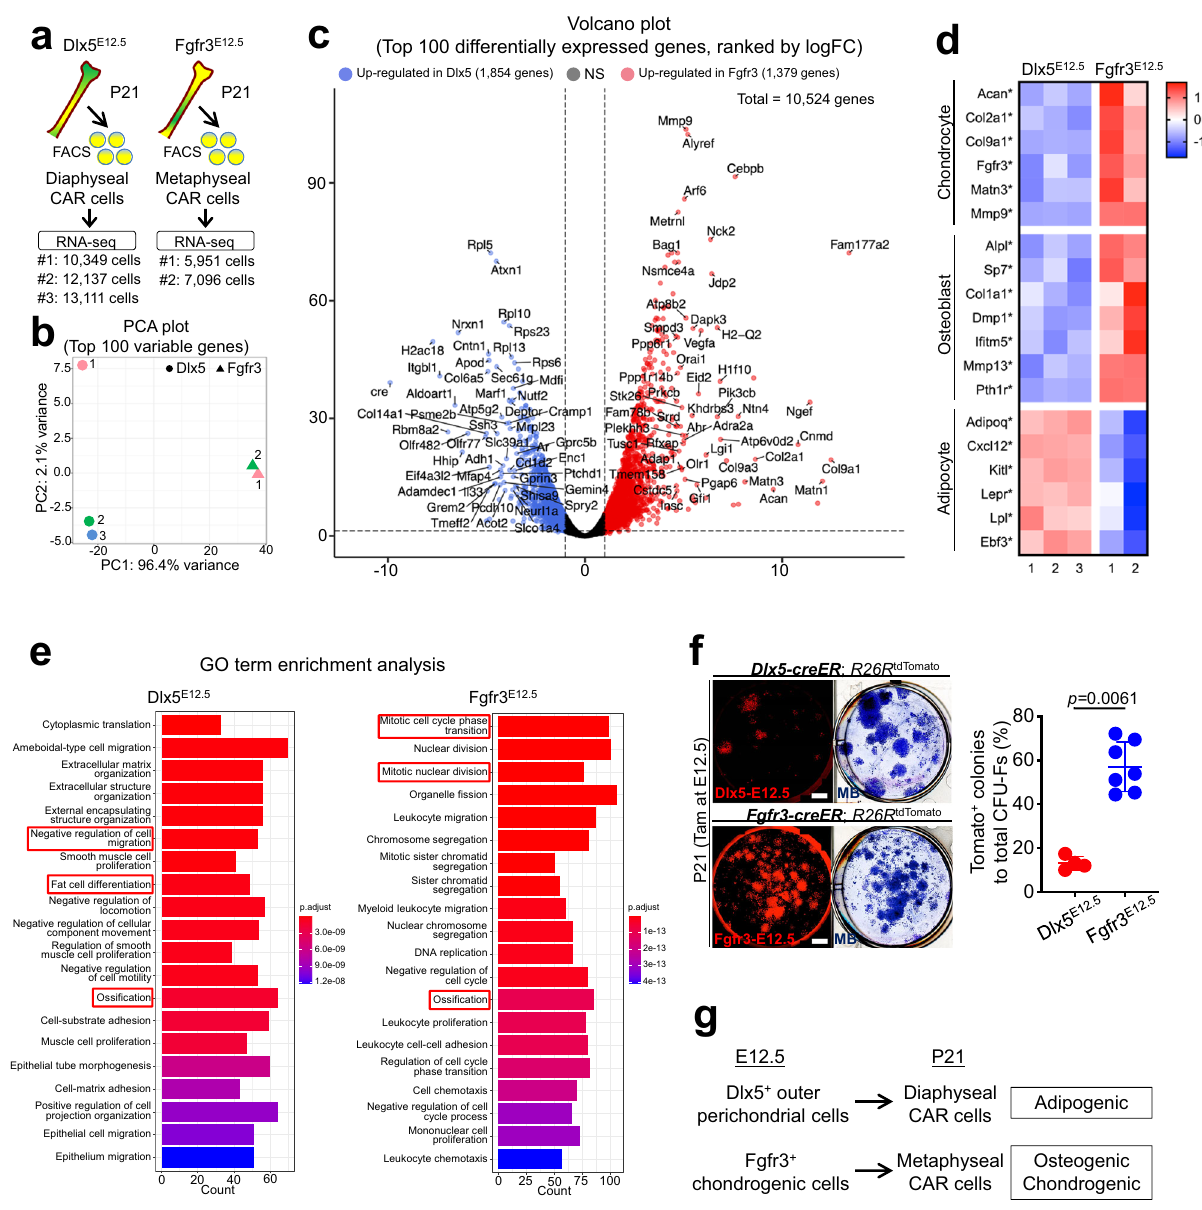
Fig. 6 | Adipocyte-biased state of Dlx5-creER + perichondrial cell-derived mar- row stromal cells. a Diagram of comparative bulk RNA-seq analysis of Cxcl12- GFP high stromal cells atP21 thatare derived from fetalDlx5 + perichondrial cells and Fgfr3 + chondrocytes. GFP high tdTomato + (Dlx5 CE -E12.5 and Fgfr3 CE -E12.5) cells were isolated from P21 Cxcl12 GFP/+ ; Dlx5-creER ; R26R tdTomato and Cxcl12 GFP/+ ; Fgfr3-creER ; R26R tdTomato femurs (pulsed at E12.5) by FACS. n =3 (Dlx5 CE -E12.5: pooled from n =4 mice), n =2 (Fgfr3 CE -E12.5: pooled from n =4 mice) biologically independent sam- ples. b Principal component analysis (PCA) plot of fi ve biologically independent samples. Circles: Cxcl12-GFP high Dlx5-E12.5 cells, Triangles: Cxcl12-GFP high Fgfr3-E12.5 cells. x -axis: PC1, 96.4% variance, y -axis: PC2, 2.1% variance. c Volcano plot for differentially expressed genes (DEGs). x -axis: log2fold-change, y -axis: -log10ad- justed p -value. Total of 10,524 genes (excluding known pseudogenes). 1379 and 1854 genes upregulated in Dlx5 CE -E12.5 (blue) and Fgfr3 CE -E12.5 (red) cells, respec- tively. Two-sided exact test for difference in means of the negative binomial dis- tribution, followed by Benjamini-Hochberg (B-H) method adjusted for multiple